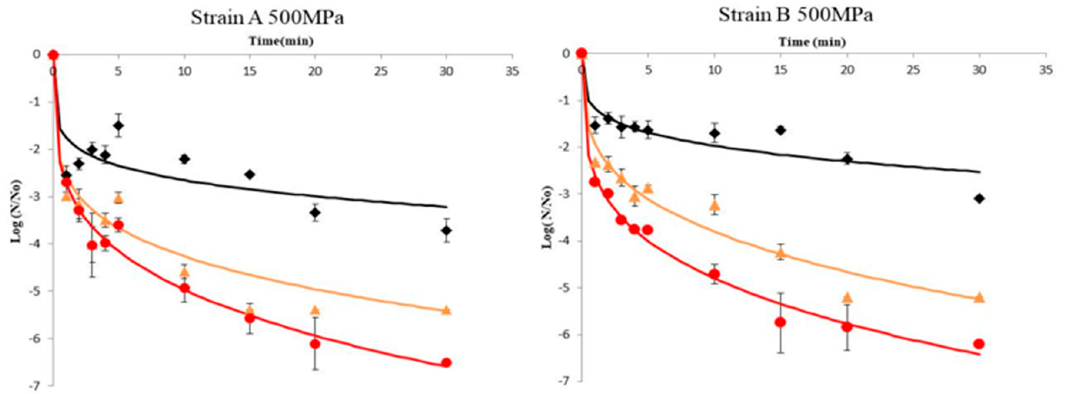
Figure 1. Inactivation curves of A. acidoterrestris spores at 500 MPa and 45 °C ( ◆ ), 60 °C ( ▲ ) and 70 °C ( ● ). Solid lines represent data fi tt ing with the Weibull model. Data are mean values of two replications ± standard deviation.